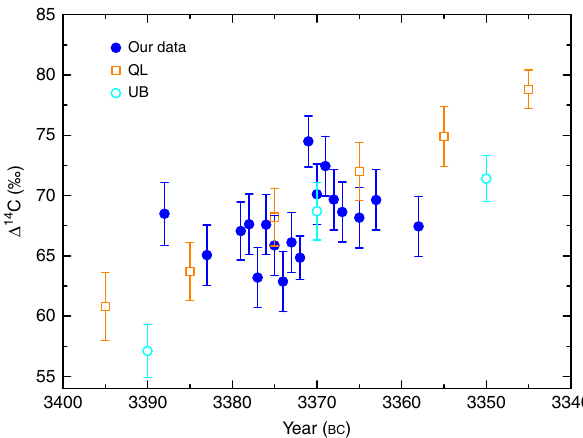
Fig. 3 Comparison with IntCal13 original data. Comparison of our data measured at the Beta laboratory ( fi lled dots) with the IntCal13 original data (The UW Quaternary Isotope Laboratory (QL, open squares) 26 , The Queen ’ s University of Belfast (UB, open dots) 27 ). For the three Δ 14 C value measured in the same year, they are consistent with each other within measurement errors. The value of Δ 14 C at BC 3385 from QL is between the nearby two points measured in Beta laboratory. Therefore, our measured results well agree with the IntCal13 original data considering the measurement errors. Uncertainties (s.d.) are based on error propagation including measurement errors of the fraction of modern carbon